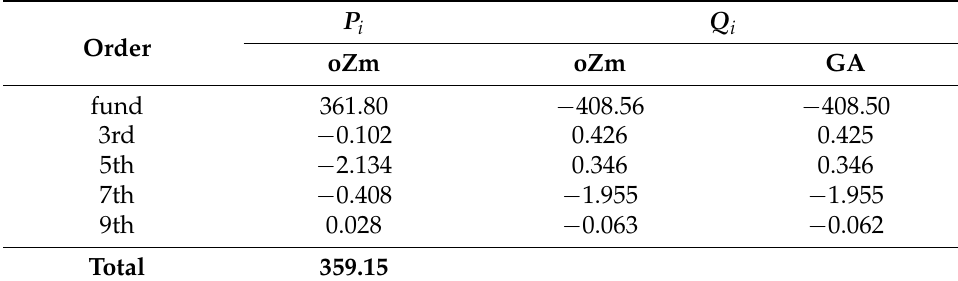
Table 4. Harmonic active (W) and reactive (VAr) power measurements.